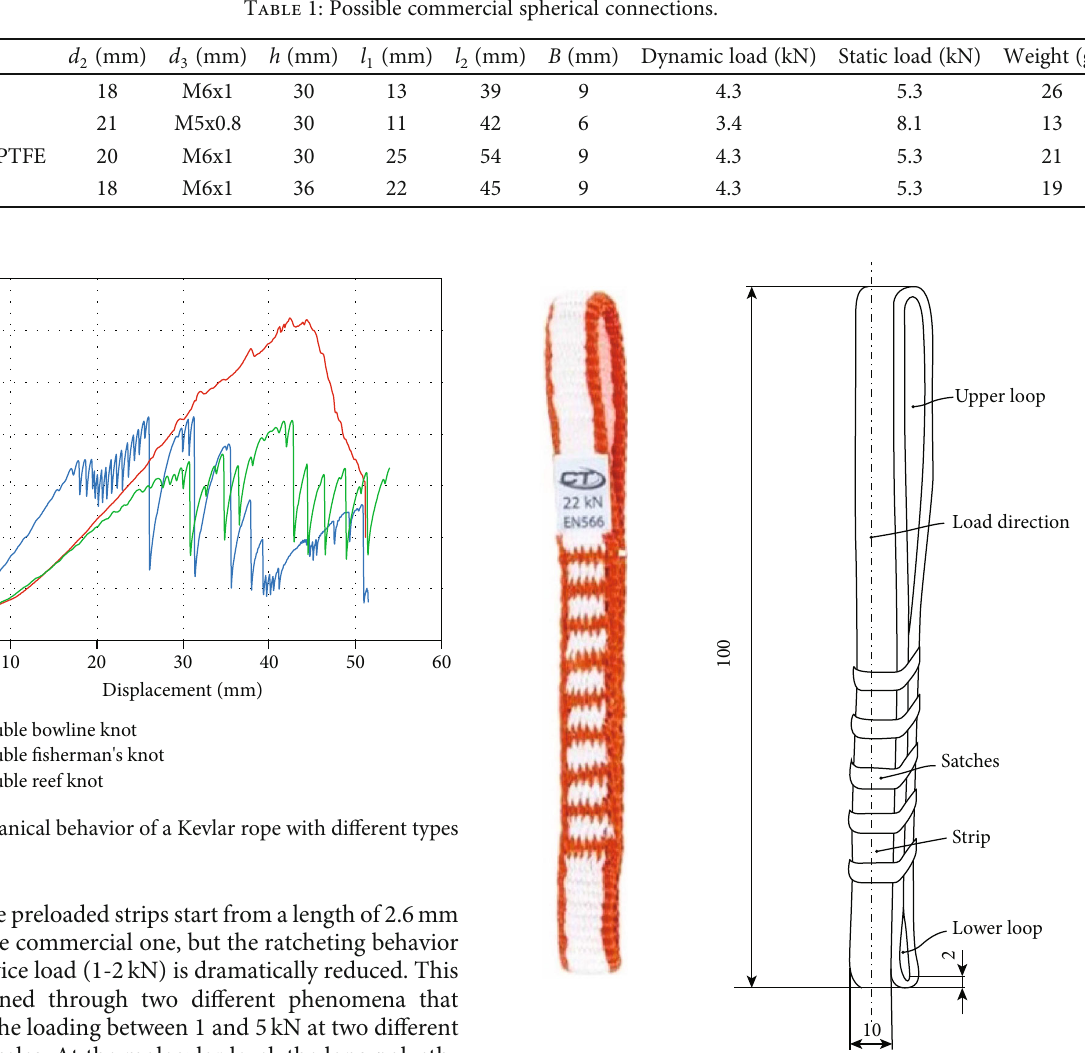
Figure 7: 22 kN rated commercial Dyneema stitched strip.